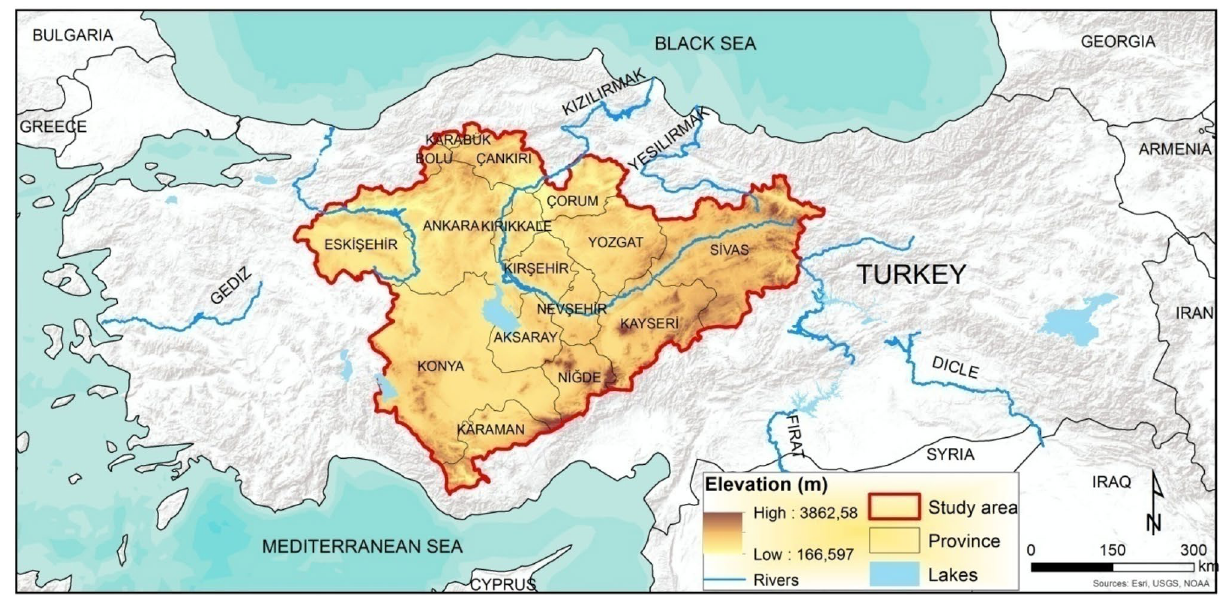
Figure 1. Location map of the study area (the map was created by the authors using the ArcGIS 10.2, http://